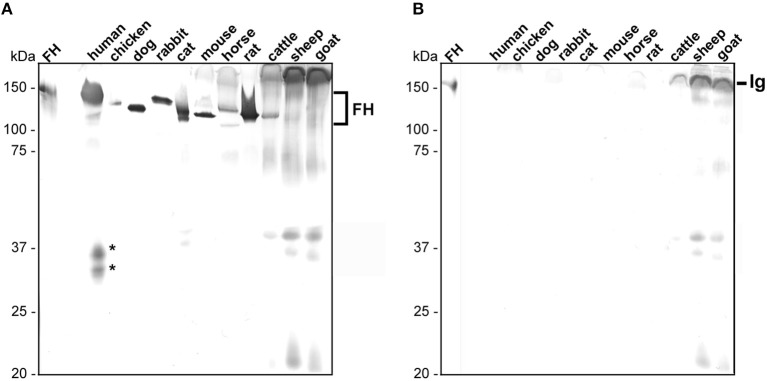
Detection of polymorphic FH in animal sera. Equal amounts of sera of different origins were loaded to two 12.5% glycine-SDS gels and separated serum proteins were transferred to nitrocellulose. (A) Human and animal FH were detected using a sheep anti-FH serum (dilution 1:500) and a secondary anti-sheep antibody (1:1,000). (B) Cross-reactivity of the secondary anti-sheep antibody to polymorphic FH molecules (dilution 1:1,000). Purified human FH (500 ng) at the left of (A,B) was used as control. Human FHR proteins are indicated by asterisks and cross-reacting immunoglobulins (Ig) from cattle, sheep, and goat are specified. The mobility of the molecular mass standard is indicated on the left.